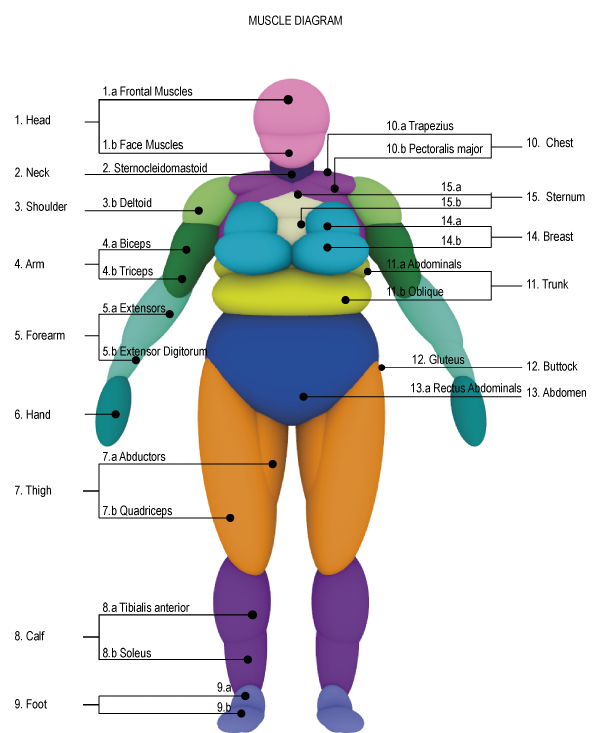
Figure 5. Map used to convert ellipsoids into cushions, topology map and ellipsoid model. Pairs of ellipsoids with same color form a